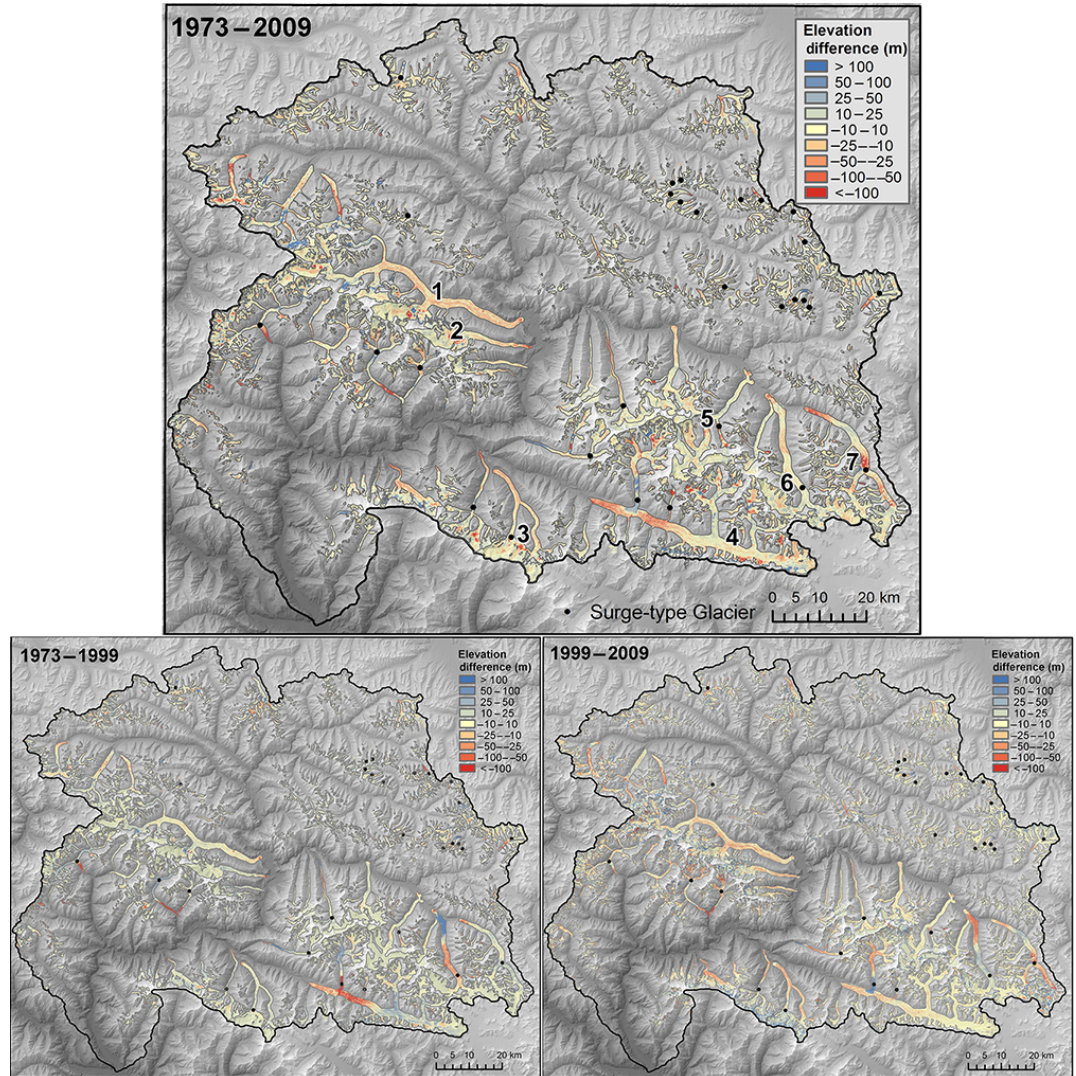
Figure 2. Elevation difference between the ASTER and Hexagon KH-9 DTMs (above), the Hexagon KH-9 and the SRTM1 DTMs (below, left) and the SRTM1 and ASTER DTMs (below, right). Black dots indicate surge-type glaciers, the numbers indicate the larger glaciers: 1 is Batura, 2 is Pasu, 3 is Barpu, 4 is Hispar, 5 is Yazghil, 6 is Khurdopin, 7 is